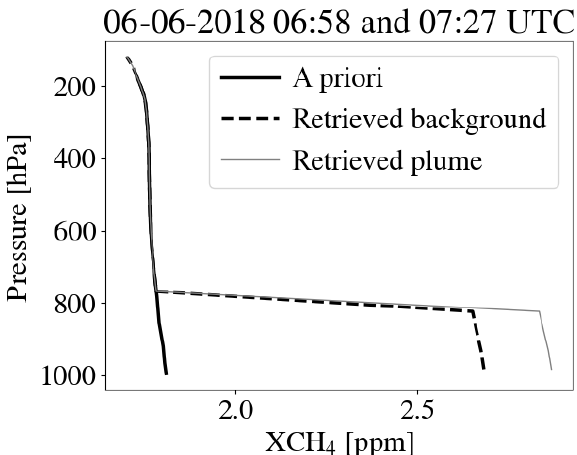
Figure A1. A priori versus retrieved CH 4 profile. Note, that the retrieval only scales the lower part of the a priori profile up to the expected maximum PBL height of roughly 800hPa (1700ma.g.l.). The grey line represents an intra-plume